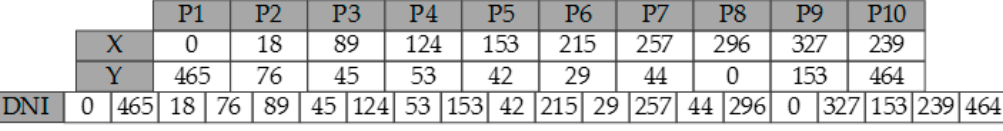
Table 1. Dynamic neuron time representation.